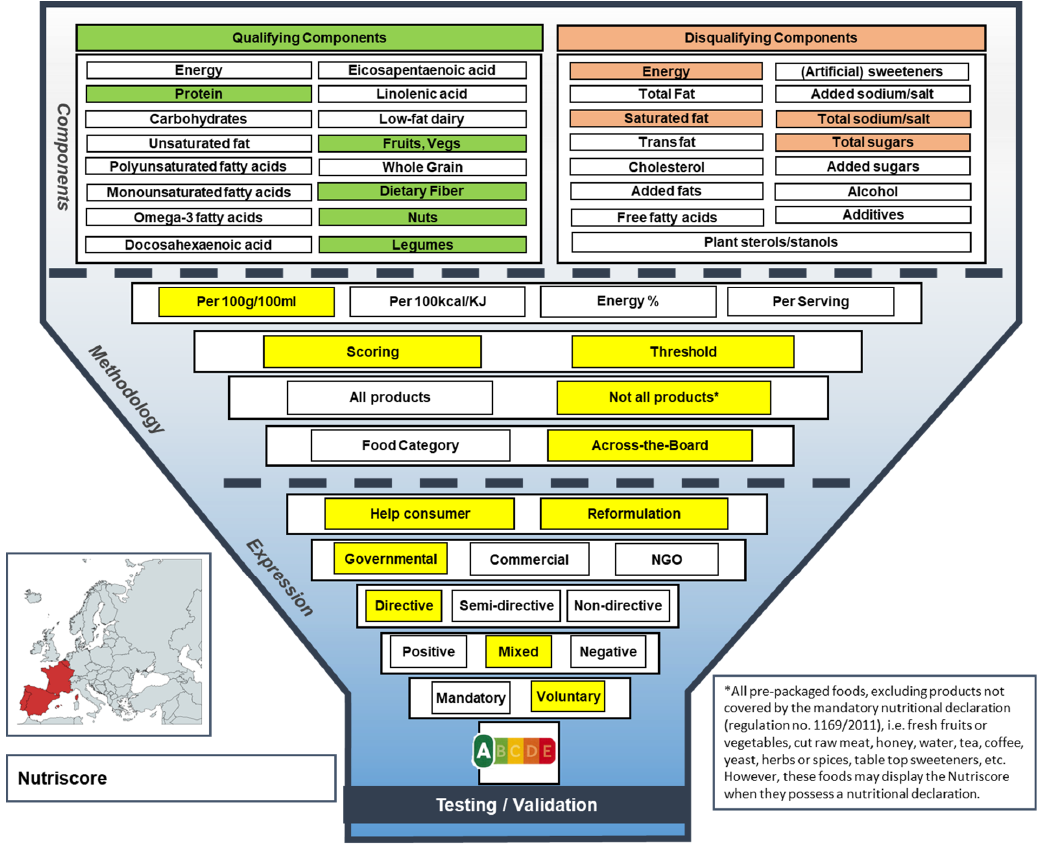
Figure 4. The Funnel Model describing functional and visual aspects of the Nutriscore label.